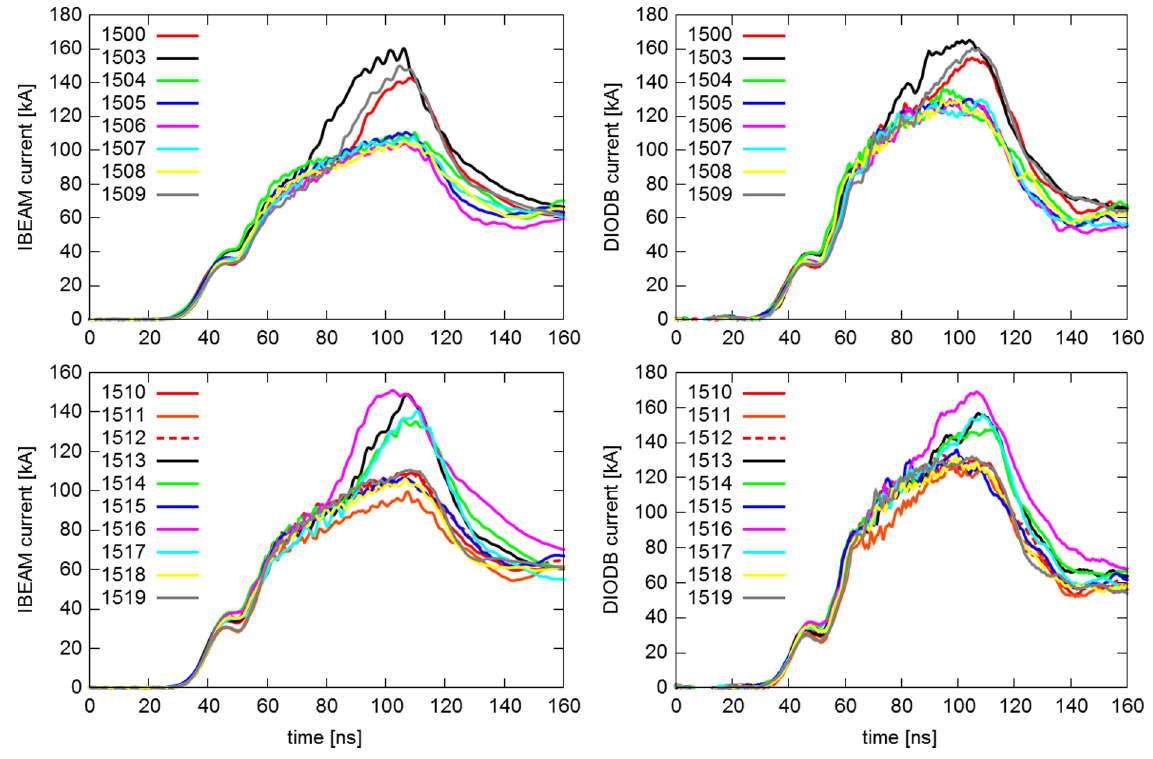
FIG. 13. The IBEAM and DIODB currents from shots 1500 through 1519. All shots are 7-7 .